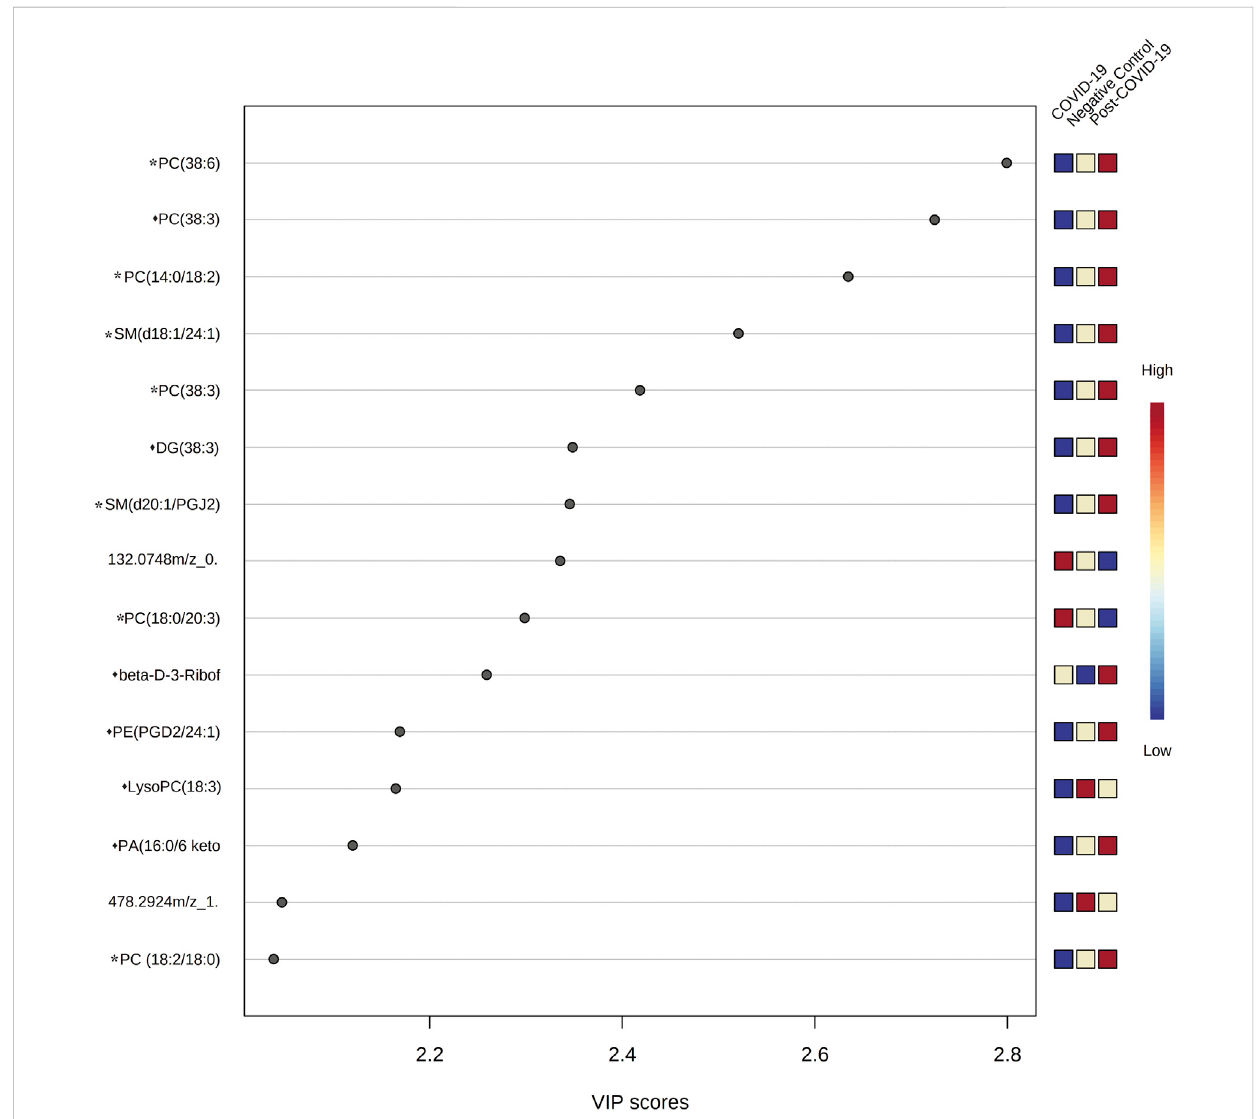
FIGURE 6 Variable importance in Projection (VIP) plot representing the rank of 15 features identi fi ed by PLS-DA according to VIP score on x -axis. The most discriminating metabolites are shown in descending score order. The color boxes indicate whether metabolite concentration was increased (red) or decreased (blue). Figures were produced in MetaboAnalyst software v 5.0 (https://www.metaboanalyst.ca/). * Represents features with con fi dence level 2 and ◆ represents features with level